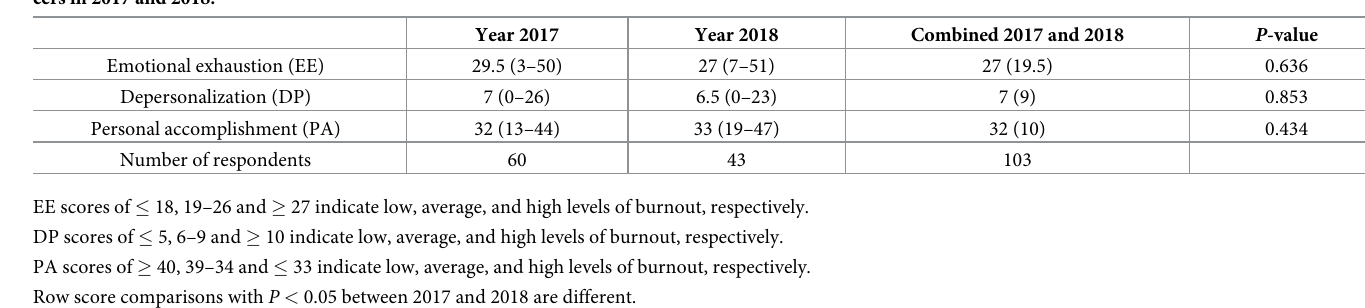
comparisons between 2017 and 2018 for MBI are summarized in Table 2. The MBI scores revealed high levels of burnout in both 2017 and 2018. The scores for emotional exhaustion ( P = 0.636), depersonalization ( P = 0.853), and personal accomplishment ( P = 0.434) were not different between 2017 and 2018. Median (IQR) for PHQ-9 scores were 7 (8.5), 7.5 (10.5) and 7 (9.8) for 2017, 2018, and combined data for the two years, respectively, indicating mild levels of depression. Gender (model P = 0.0412) was a significant predictor of emotional exhaustion scores for the MBI, with higher scores reported in males compared to females (33.8 vs 26.9; P = 0.035). Gender was a significant predictor of PHQ-9 scores, with higher scores reported in males com- pared females (11.5 vs 7.8; P = 0.027). Gender was also a predictor of GAD-7 scores with higher scores reported in males compared to females (10.1 vs 6.9; P = 0.040). Marital status (model P < 0.0001) was significant predictor of emotional exhaustion (32.4 vs 26.5; P < 0.033) and depersonalization (11.2 vs 7.5; P = 0.011) scores of the MBI (burnout) with higher scores reported in married compared to single respondents for both subscales. Marital status was also a predictor of personal accomplishment subscale of MBI with higher scores reported in single compared to married respondents (32.8 vs 28.6; P = 0.010). Marital status was also a predictor of mental component summary subscale of the quality of life (Short